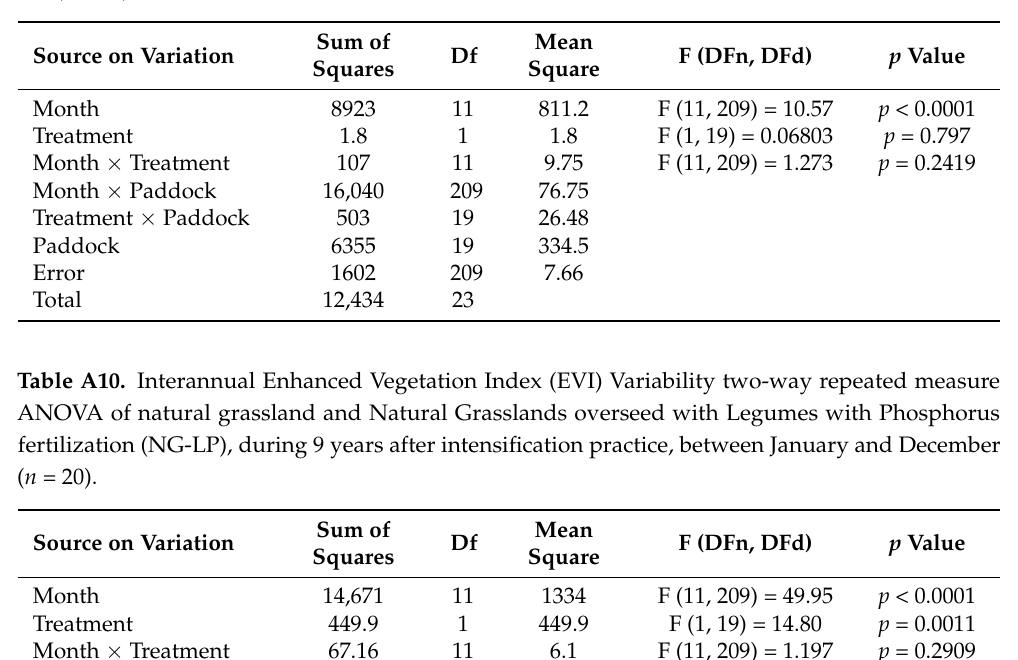
Table A9. Interannual Enhanced Vegetation Index (EVI) Variability two-way repeated measure ANOVA of natural grassland, 4 years before to intensification practice, between January and Decem- ber ( n = 20).